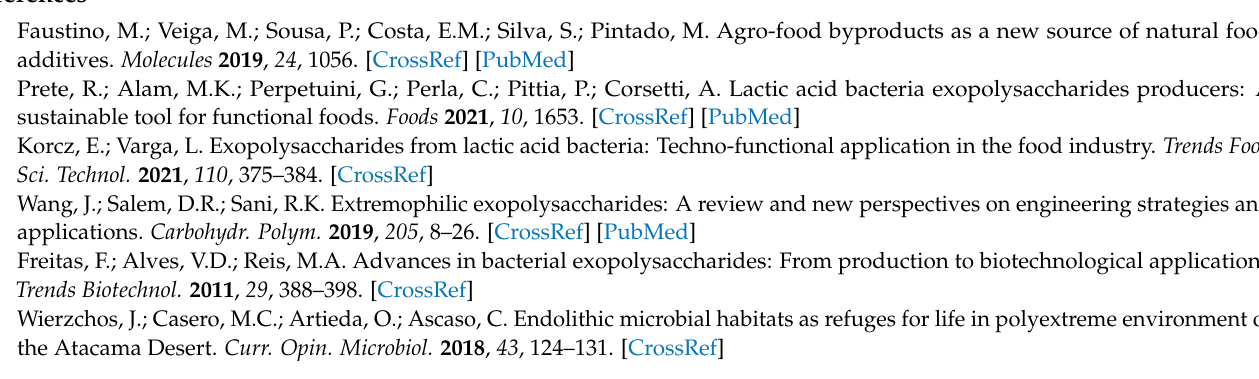
Figure S1B: COSY spectrum of EPS produced by B . haynesii EPS. Figure S1C: 13 C NMR spectrum of EPS obtained at 60 ◦ C in 2 H 2 O. Table S1A: Concentration of different metals (Al, As, Cd, Cu, Cr, Fe, Mg, Mn, Hg, Ni, Pb, and Zn) (mg L − 1 ± S.D.) (n = 2) in the water sample collected from Campanario hot spring in the Maule region, Chile. Table S1B: The physicochemical parameters (n = 2) of the water sample collected from Campanario hot spring of Maule region,